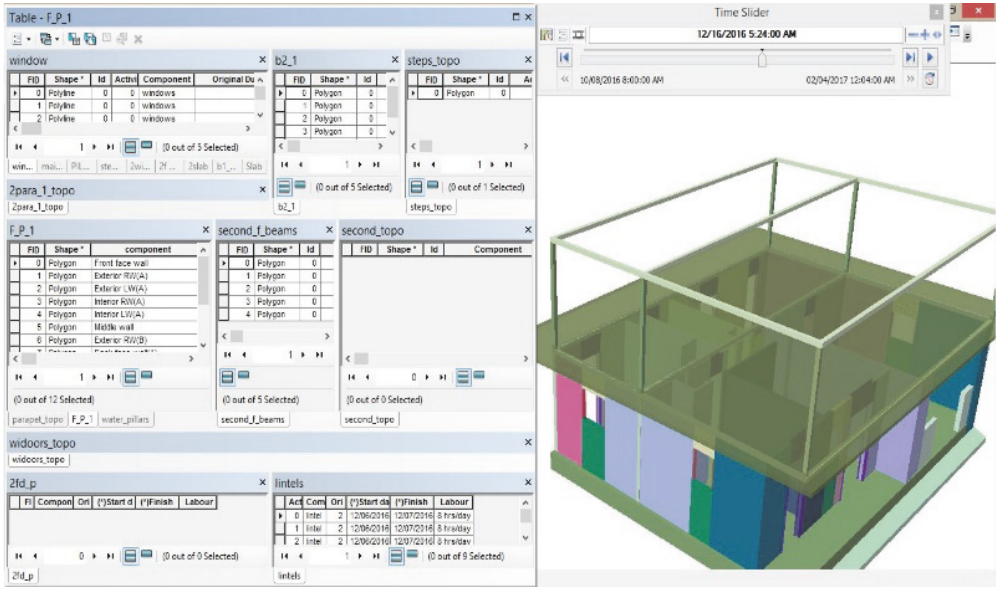
Figure 7: Extrusion of second floor components.